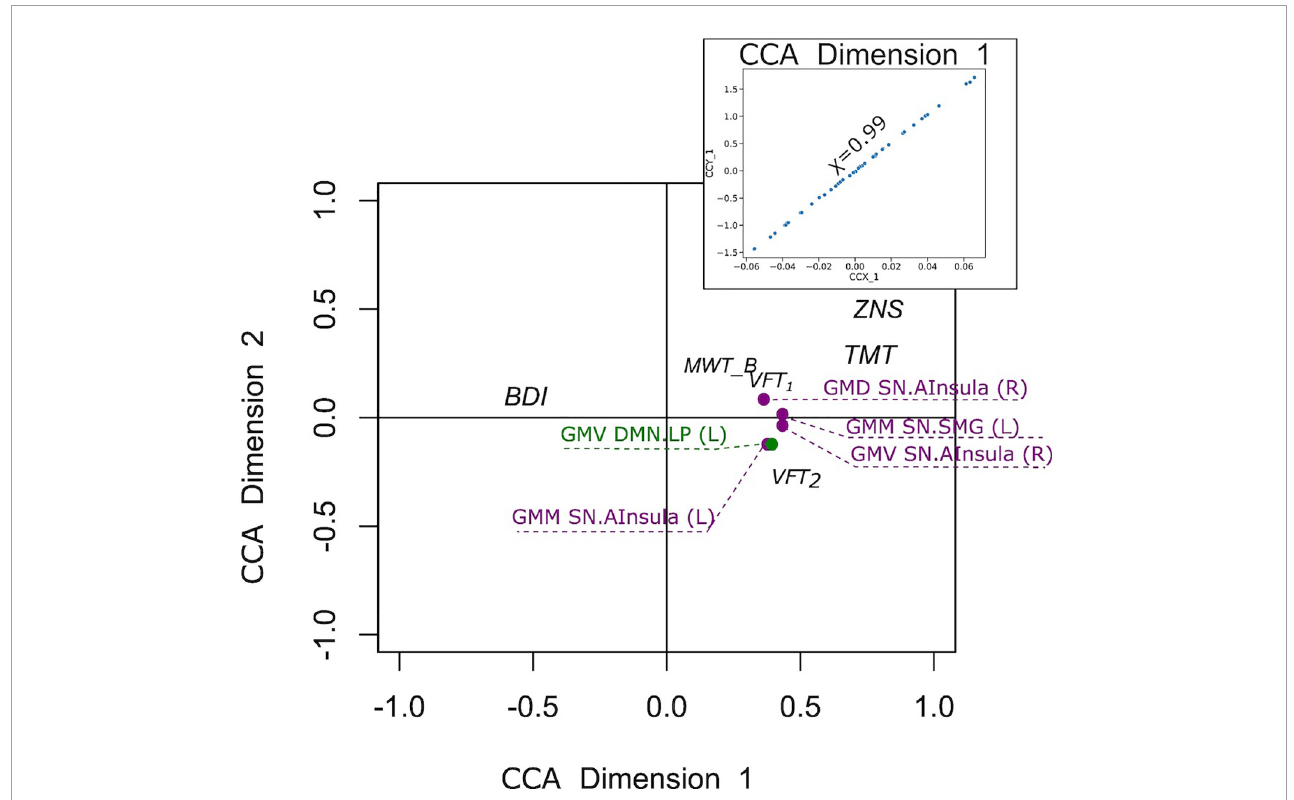
FIGURE8 Correlation of the first canonical correlation analysis (CCA) mode variables for the sample of subjects with a current psychiatric diagnosis (upper right), and contributions of the variables to the first and second CCA